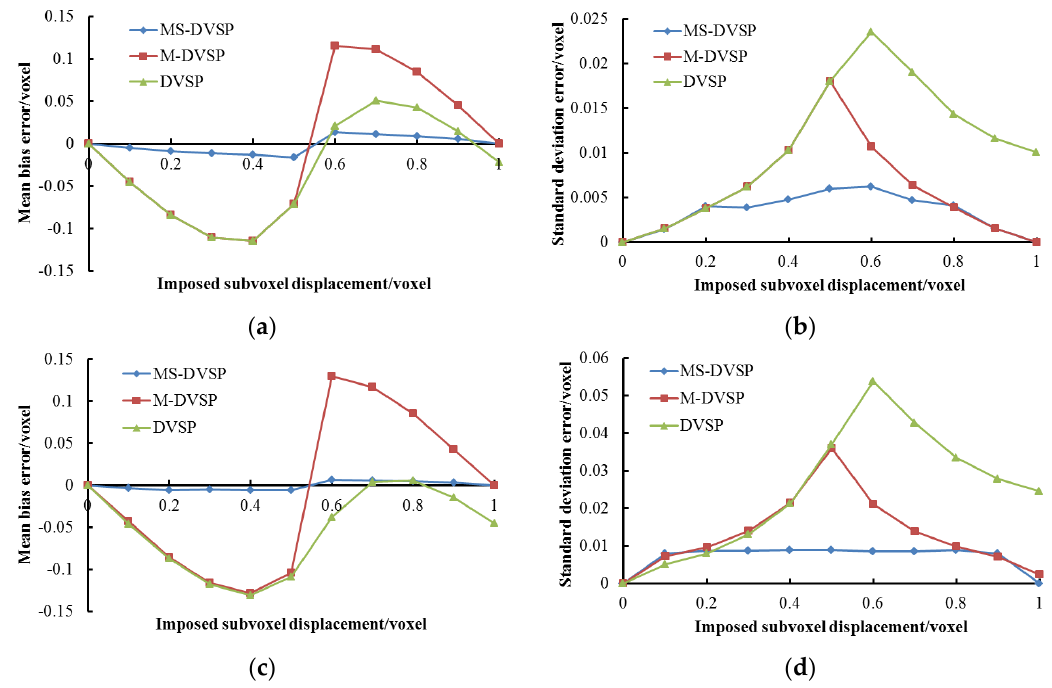
Figure 13. Accuracy comparison among MS-DVSP, M-DVSP and DVSP algorithm: ( a ) Mean bias error of displacement of the red sandstone specimen; ( b ) Standard deviation error of displacement of the red sandstone specimen; ( c ) Mean bias error of displacement of the woven composite specimen; ( d ) Standard deviation error of displacement of the woven composite specimen.